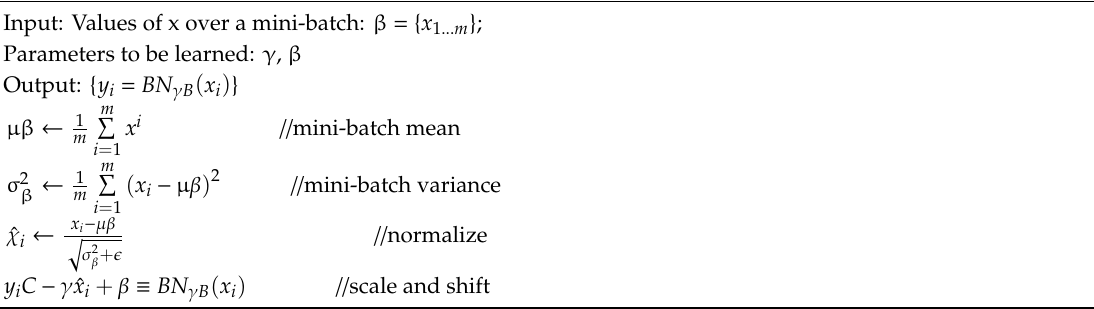
Algorithm 1. Batch normalizing transform applied to the activation x over a Figure 6. Neural network model of dropout.